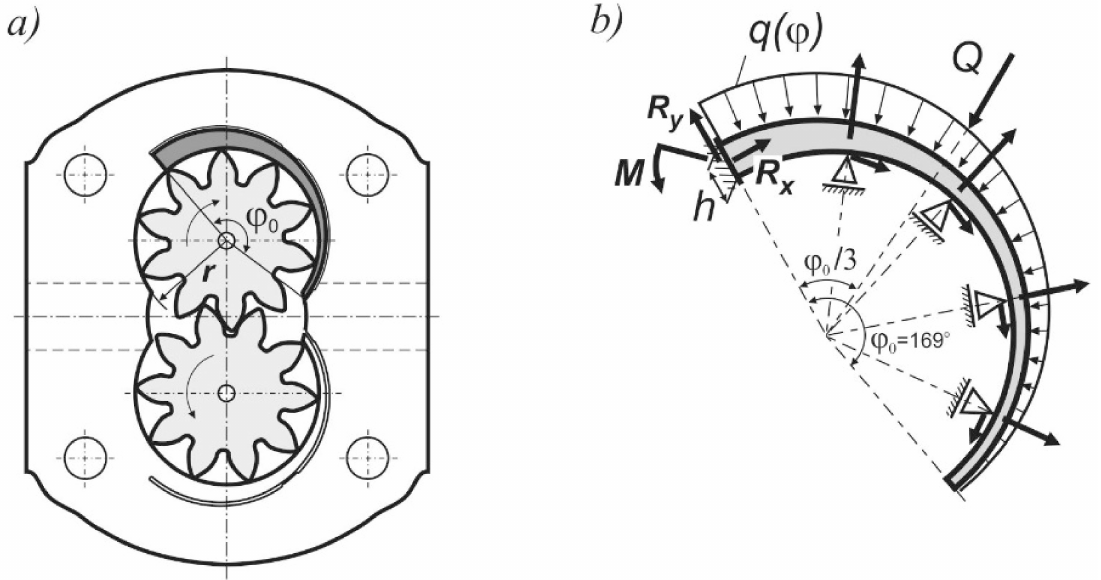
Figure 6. Diagram of the gear pump with circumferential backlash compensation and with the lip (indicated in gray color) having the wrapping angle ϕ o of 169 ◦ : ( a ) gear position most unfavorable for the loaded lip; and ( b ) static mechanical system of the lip. Symbols: h , lip thickness in the restraint cross-section; q( ϕ ), continuous load due to pressure differences on the two lip sides; Q , resultant force of the continuous load; R x , R y , M , internal forces in the restraint; r , radius of the internal working space of the gear